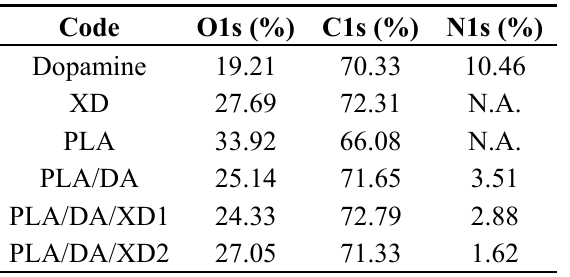
Table 2. Surface chemical composition of XD immobilized on polydopamine (PDA)-coated PLA scaffolds by XPS.